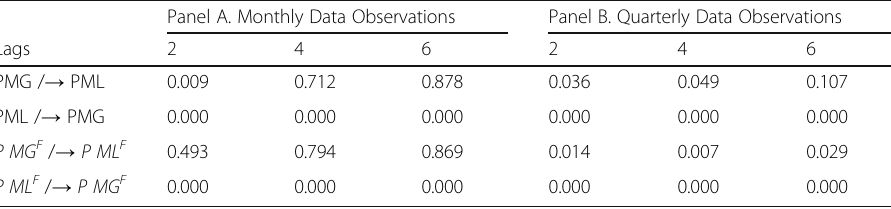
Table 5 Granger Causality Tests on PMG and PML. Decomposition with High Price Extremes Panel A. Monthly Data